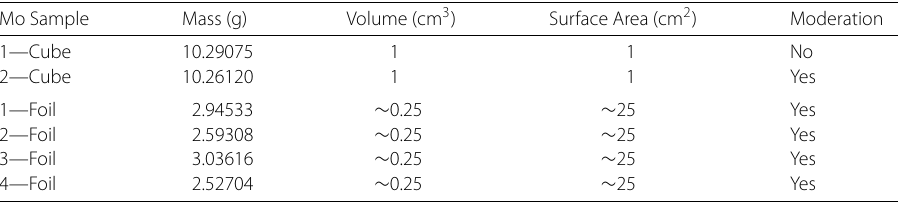
Table 1 Characteristics of Mo cube and foil samples used in irradiation experiments Mo Sample Mass (g) Volume (cm 3 ) Surface Area (cm 2 ) Moderation 1—Cube 10.29075 1 1 No 2—Cube 10.26120 1 Yes 1—Foil